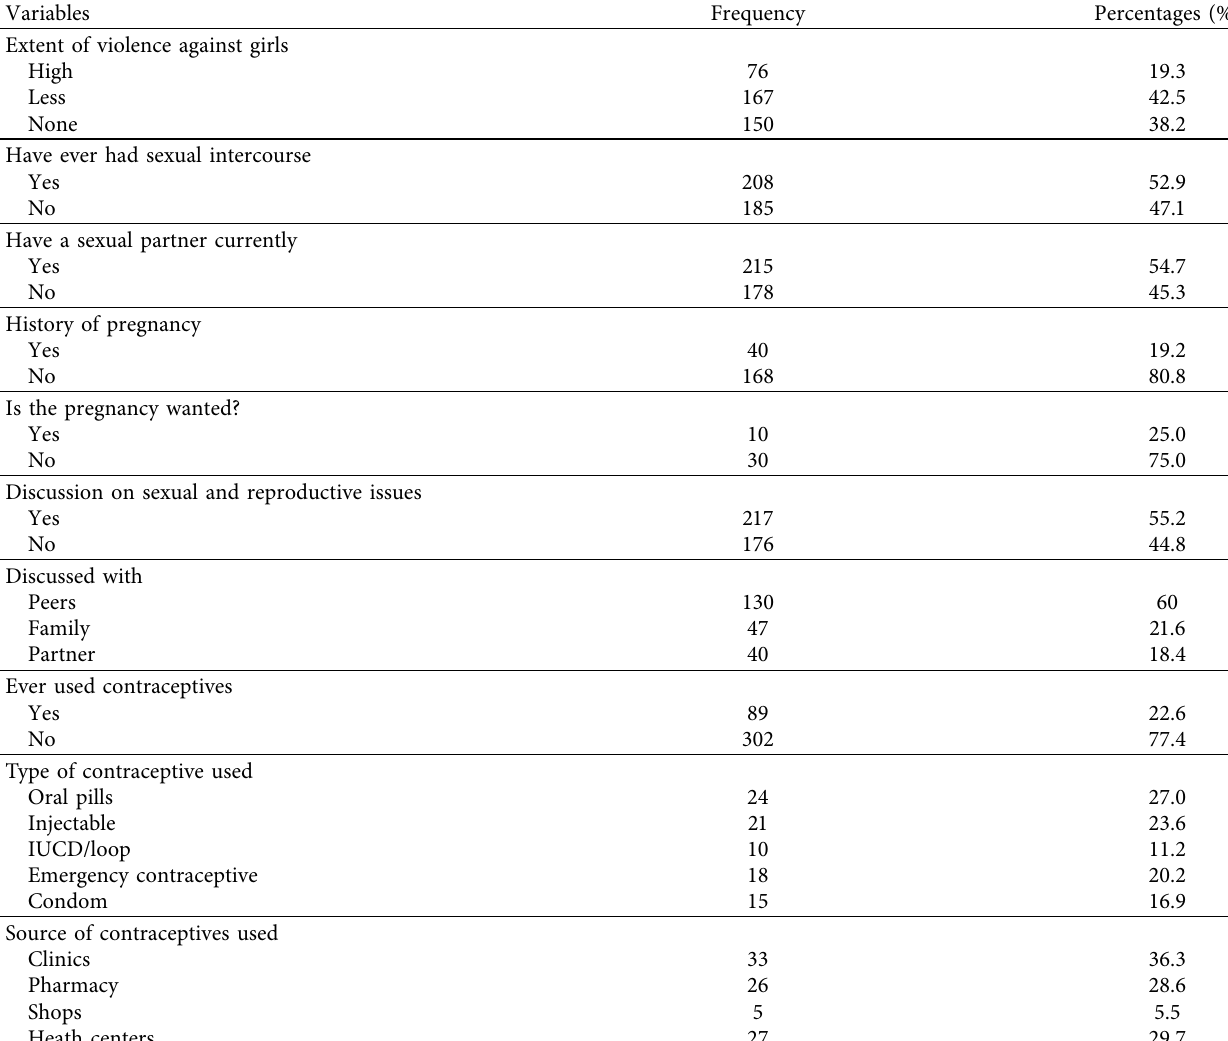
Table 4: Sexual and reproductive health right practice among female preparatory school students, Assela, Ethiopia, 2015.